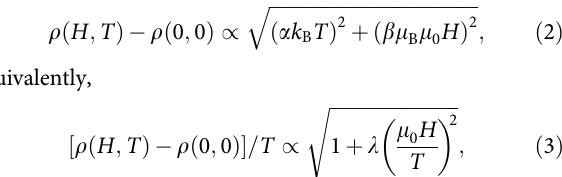
ffiffiffiffiffiffiffiffiffiffiffiffiffiffiffiffiffiffiffiffiffiffiffiffiffiffiffi